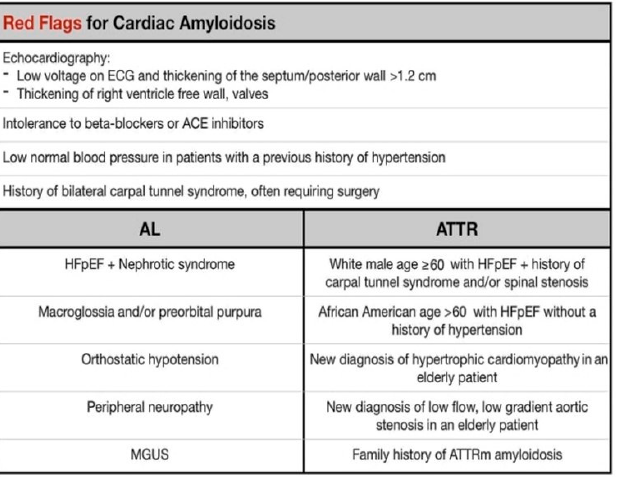
Figure 1. Red Flags for cardiac amyloidosis.